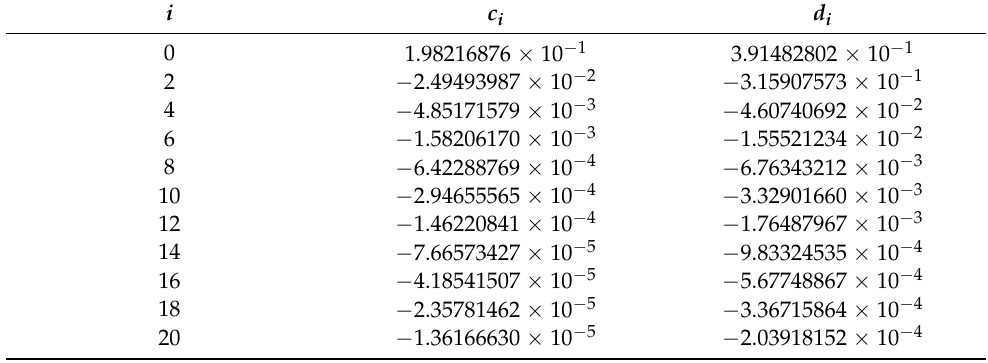
Table 2. Numerical values of c i and d i when c 0 = 1.98216876 × 10 − 1 , d 0 = 3.91482802 × 10 − 1 and H = 300 mm.